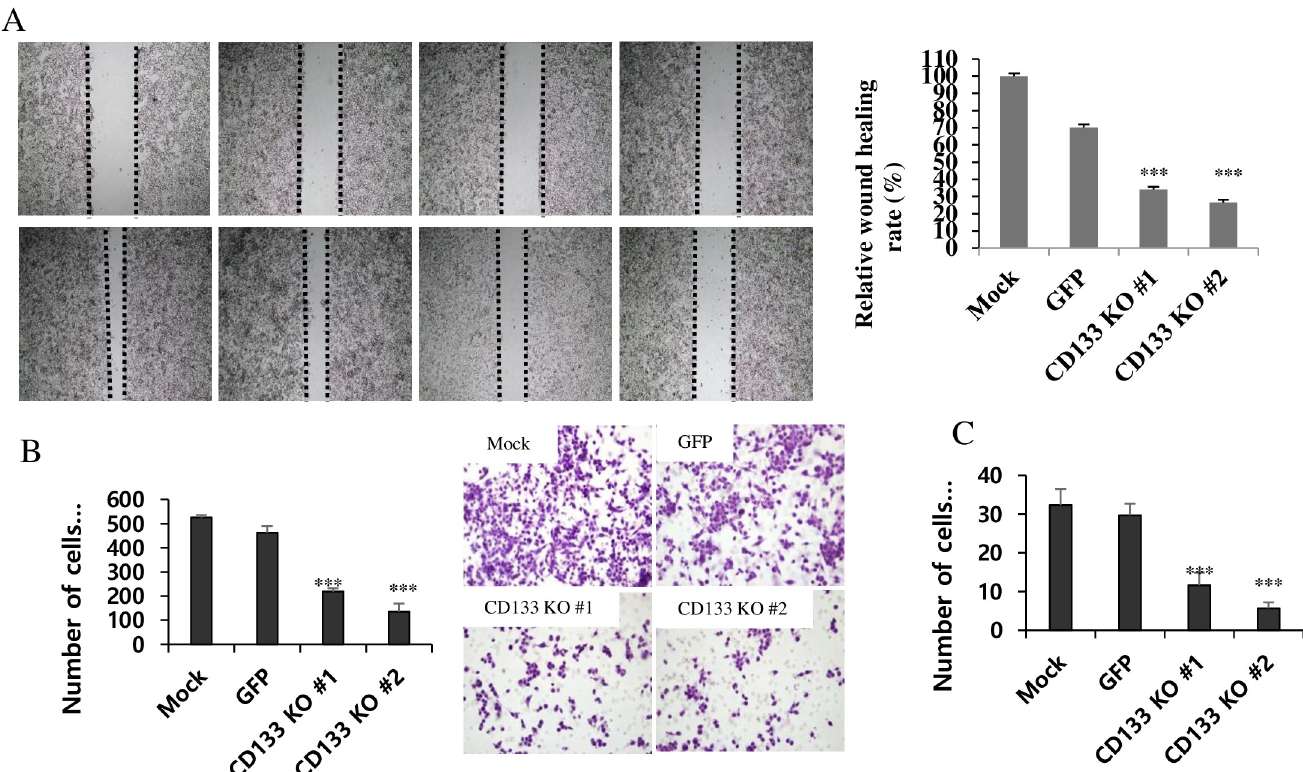
Fig 4. CD133 knockout inhibits cell migration and invasion. ( A ) Photographs at 0 and 24h after wounding demonstrated that CRISPR-Cas9 mediated CD133 knockout cells showed significantly decreased wound healing rate compared to the control ( ��� P < 0.001). ( B ) CD133 knockout cells had the least average number of migrating cells among the three groups in transwell migration assay ( ��� P < 0.001). ( C ) In transwell invasion assay, the average number of invasive cells in CD133 knockout group was 11.67 and control cells were 32.33 and 29.67, respectively ( ��� P < 0.001).